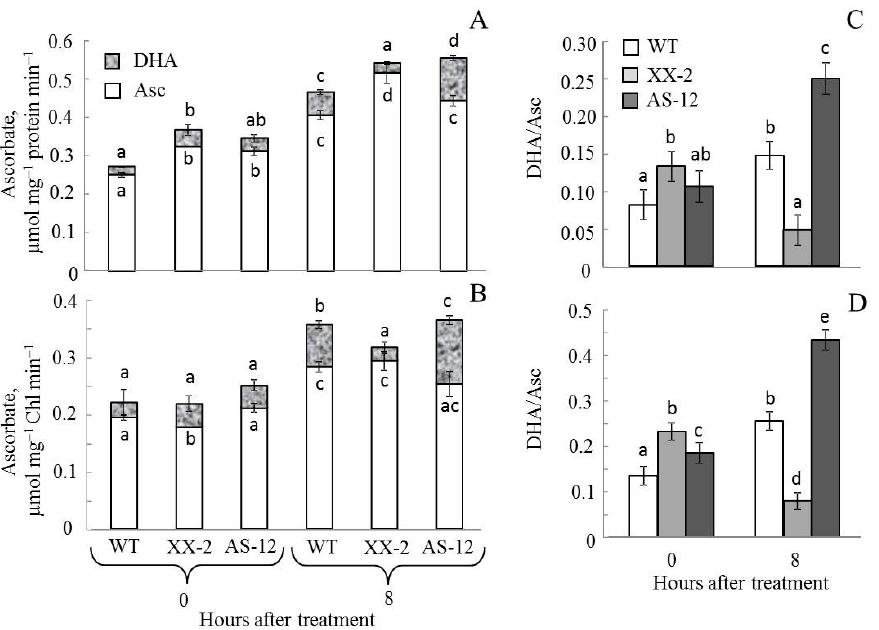
Figure 8. Changes in reduced (Asc) and oxidized (DHA) ascorbate pools per mg of chloroplast protein ( A ) and per mg of Chl ( B ) in chloroplasts isolated from leaves of WT, XX-2, and AS-12 Ar- abidopsis thaliana plants grown at 90 μ mol m − 2 s − 1 (0 h) and after 8 h of moderately high light expo- sure (400 μ mol m − 2 s − 1 ). ( C , D ) The relative ascorbate content (Asc/(Asc + DHA), Asc red ) per mg of chloroplast protein and per mg of Chl, respectively. Data are presented as mean ± SE of values from three independent experiments (n = 6 for each experiment). Significant differences between mean values (ANOVA, Duncan’s test, p < 0.05) are indicated by different letters (a, b, c, d, e). The same or double letters (ab, ac) indicate no significant differences between the means.